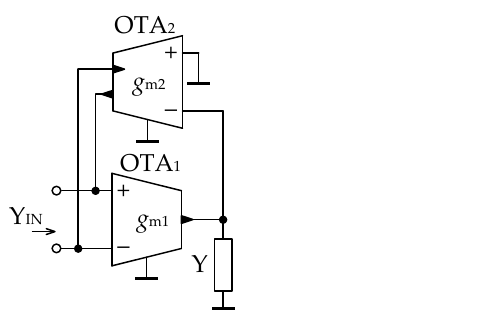
Figure 8. A differential (floating) variant of the gyrator from Figure 2.